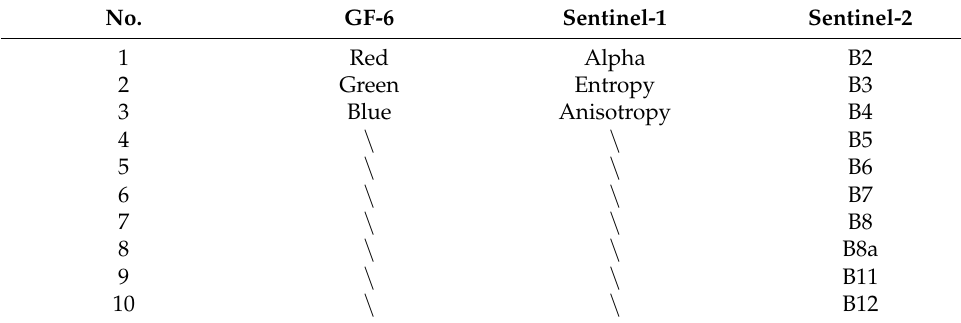
Table 1. The bands used in GF-6, Sentinel-1, and Sentinel-2. No. GF-6 Sentinel-1 Sentinel-2 1 Red Alpha B2 2 Green Entropy B3 3 Blue Anisotropy B4 4 \ \ B5 5 \ \ B6 6 \ \ B7 7 \ \ B8 8 \ \ B8a 9 \ \ B11 10 \ \